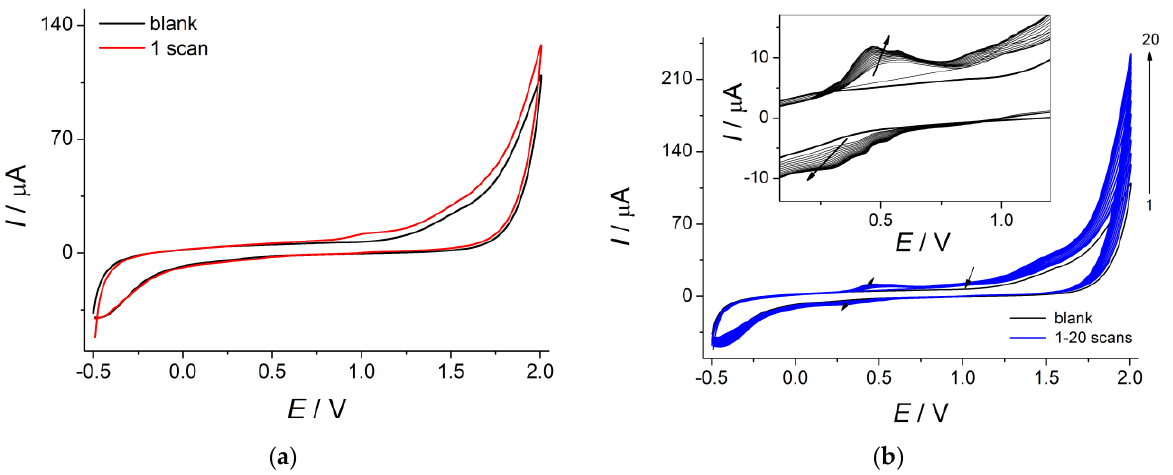
Figure 2. Electropolymerization of 100 µM p -ABA at the MWCNTs/GCE in Britton – Robinson buffer pH 2.0: ( a ) First cycle of electropolymerization; ( b ) Twenty cycles of electropolymerization. The inset is the enlarged scale of voltammograms in the potential range of 0.1 – 1.2 V. Potential scan rate is 100 mV s – 1 .